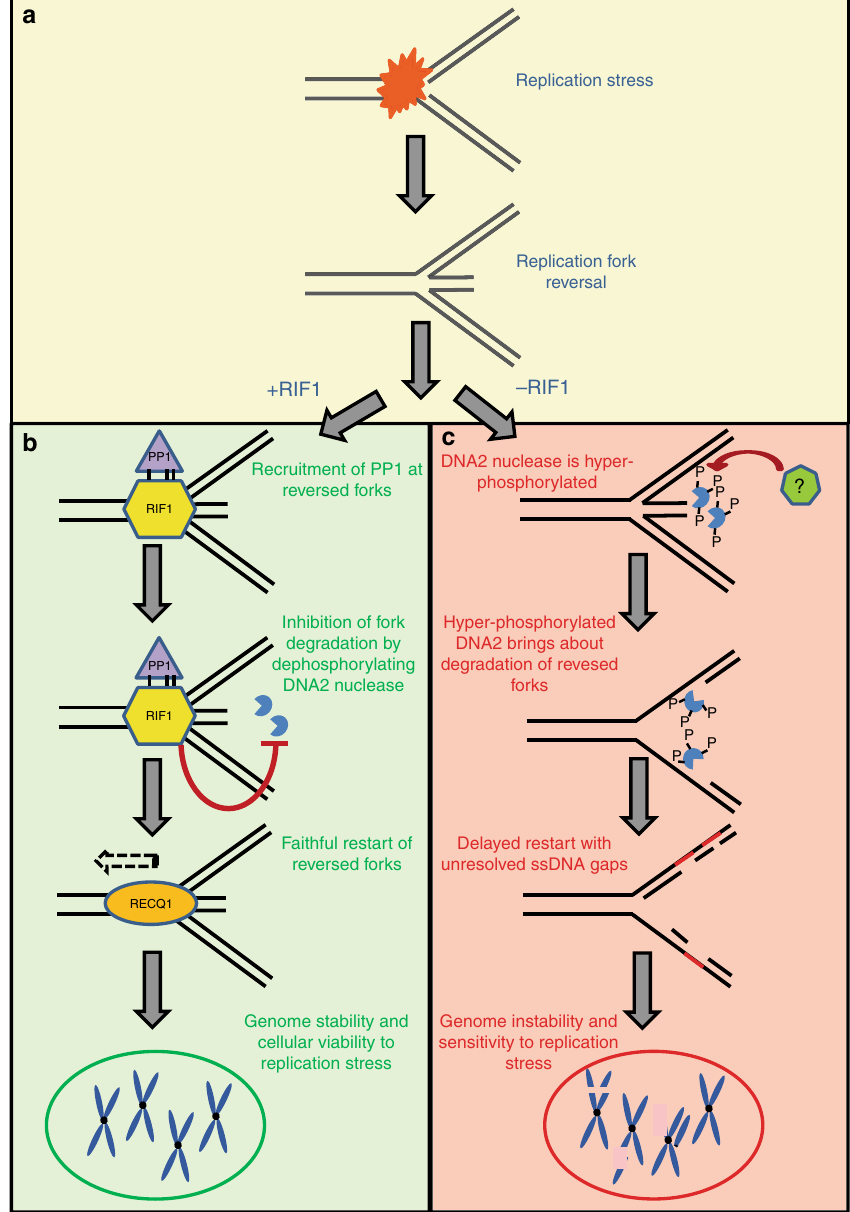
Fig. 7 Model for role of RIF1 in fork protection and genome stability. a Replication stress in cells results in replication fork reversal to stabilize stalled replication forks. b Fork reversal results in the recruitment of RIF1 probably through its C-terminal domain, which has cruciform structure